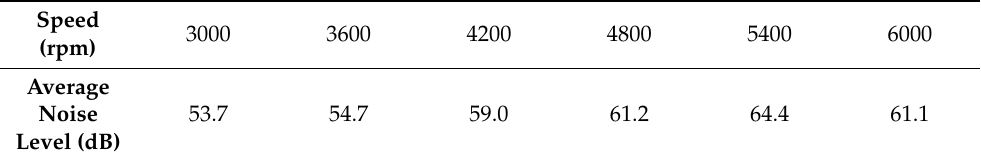
Table 5. The average background noise of different motor speeds in the open